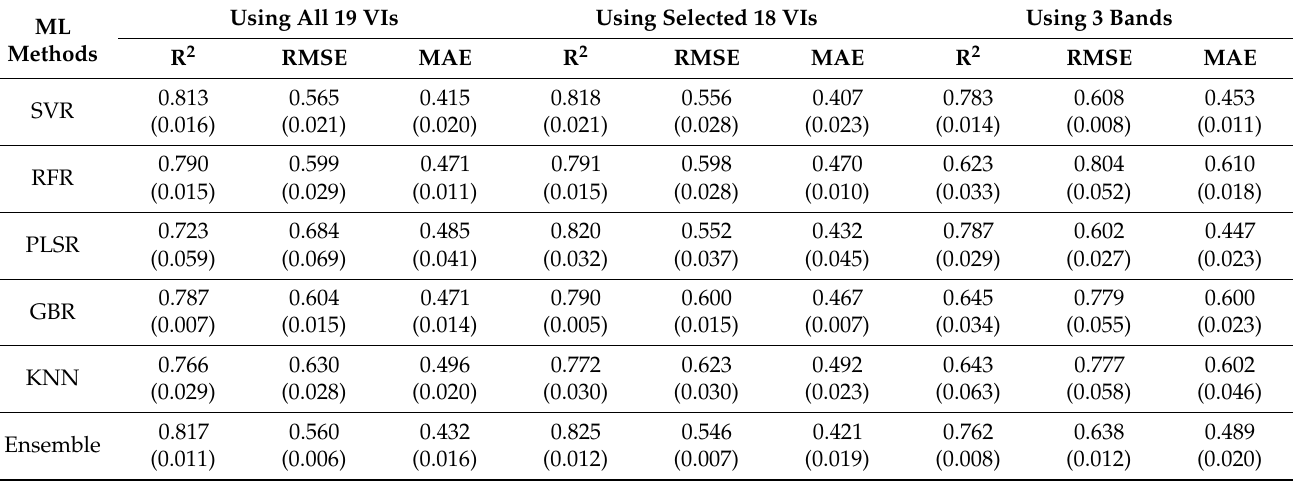
Table A1. Test accuracies including mean and standard deviation of five base models and an